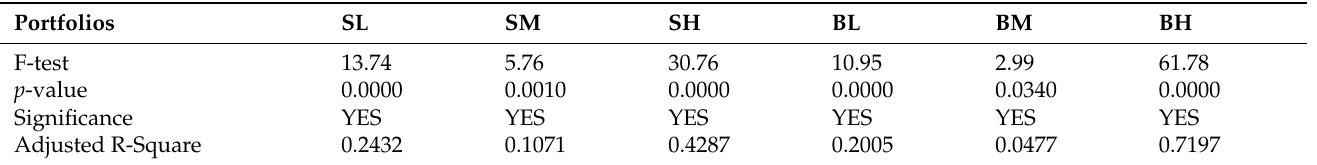
Table 7. Fama-French Three-Factor Regression Model.